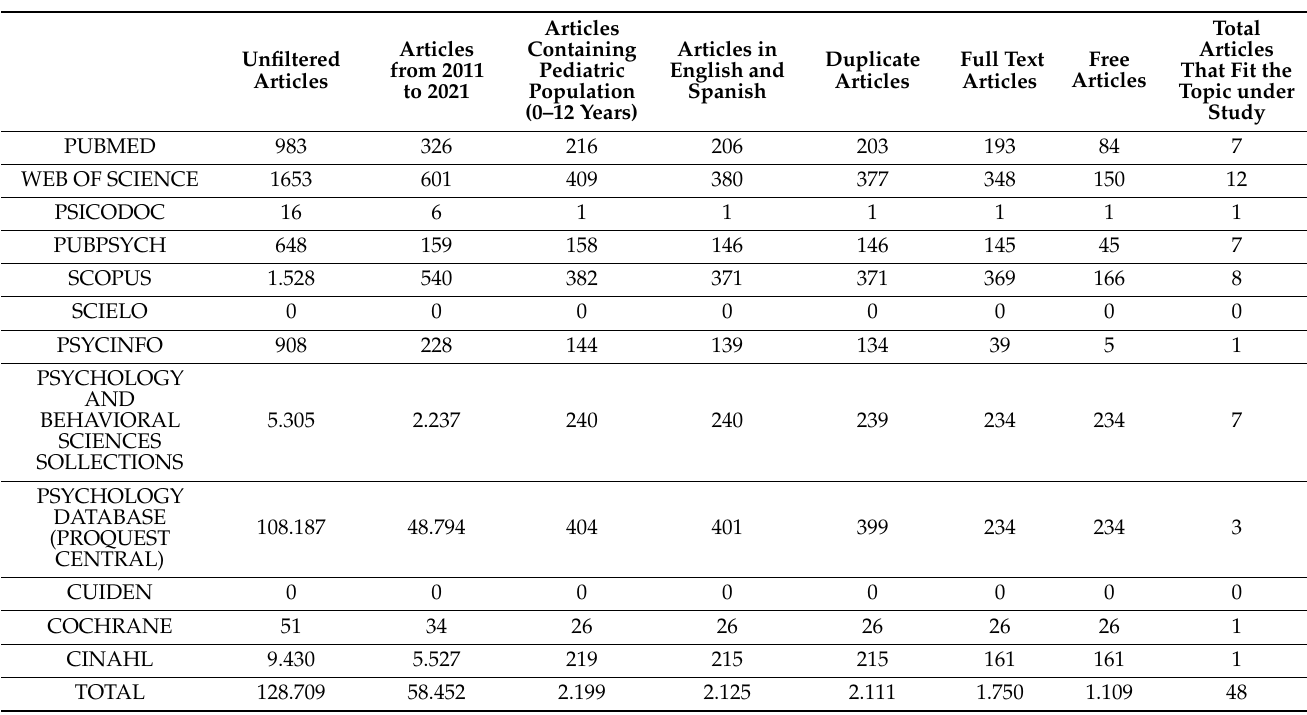
Table 2. Article selection